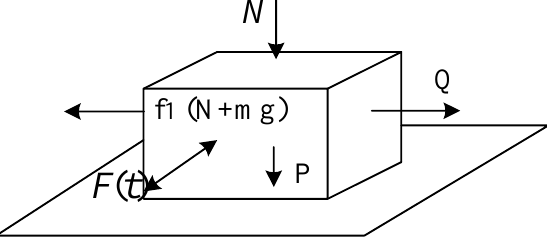
Figure 3. The model of vibration vertical to the friction and the normal pressure.